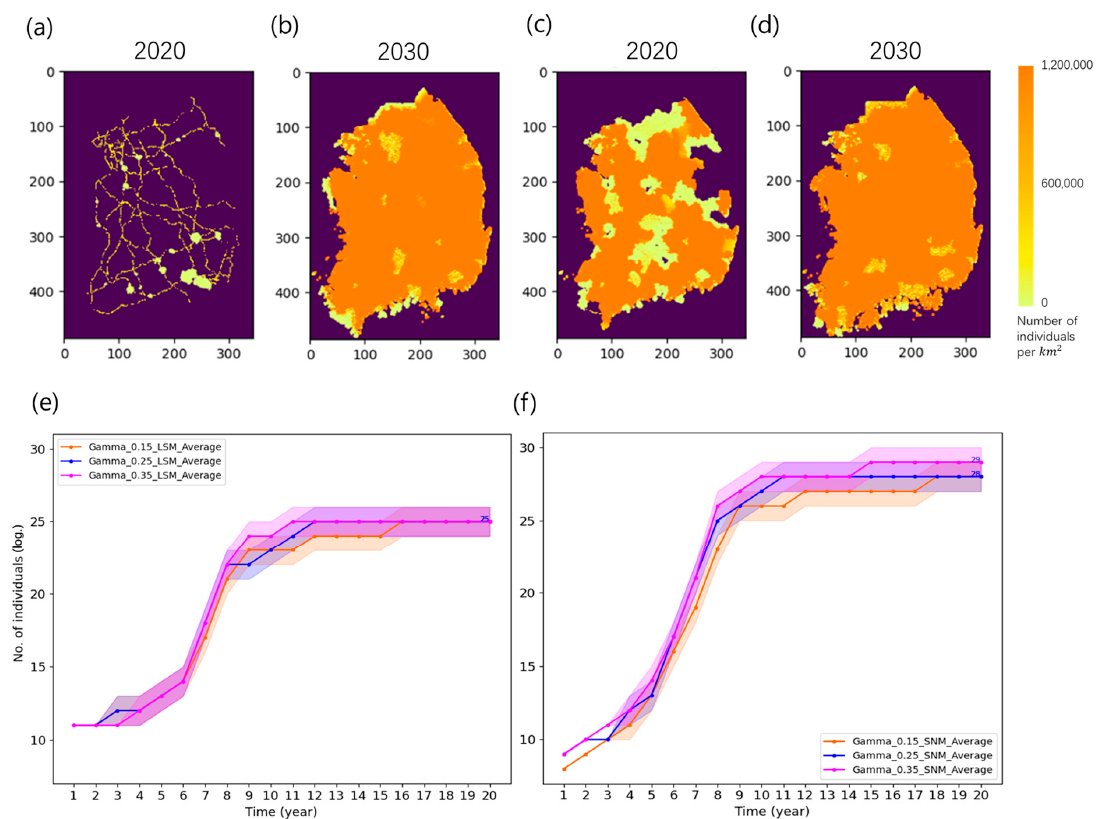
Figure 9. Simulating advancement patterns of WCSB populations with γ = 0.15 in 2020 ( a ) and 2030 ( b ), and with γ = 0.35 in 2020 ( c ) and 2030 ( d ) in the southern Korean peninsula starting from 2010 (Allee threshold; 1000 individuals per spatial unit). (Horizontal and vertical units in two-dimensional maps are expressed in km for convenience of illustration.) Changes in population size (log.) of WCSB with different conditions of γ (0.15 and 0.35) in the southern Korean peninsula between 2011–2030, starting from 2010 according to LSM ( e ) and SNM ( f